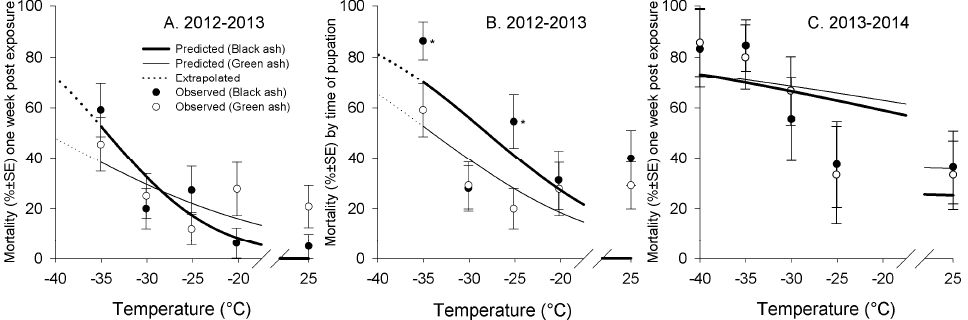
Figure 2. Mortality of A. planipennis larvae from black and green ash in the winters of 2012–2013 and